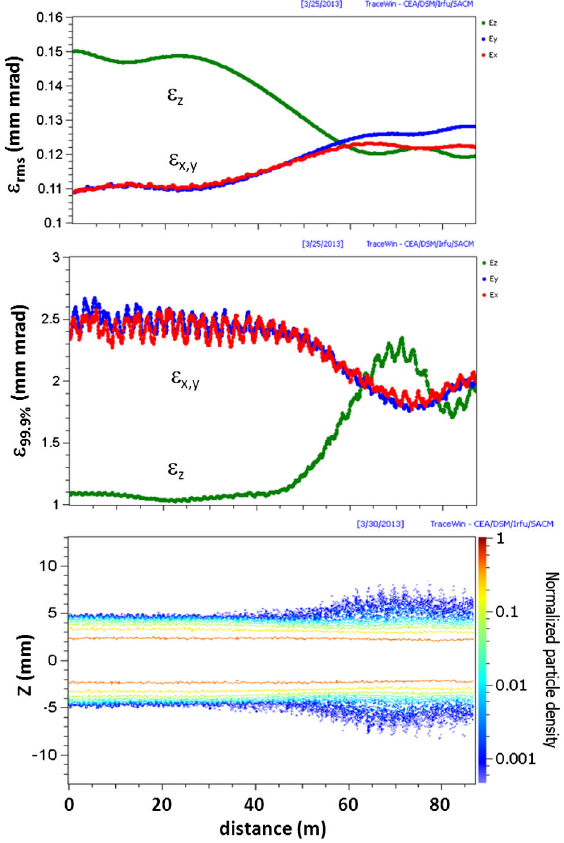
FIG. 4. Extra halo added in transverse plane only: rms (top) and 99.9% (center) emittances, and projection of z evolution (bottom).